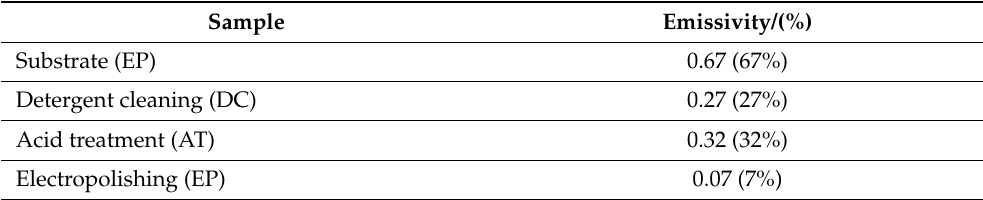
Table 5. Average emissivity (%) of EP Substrates and DC, AT, and EP samples (1 min of deposition time).